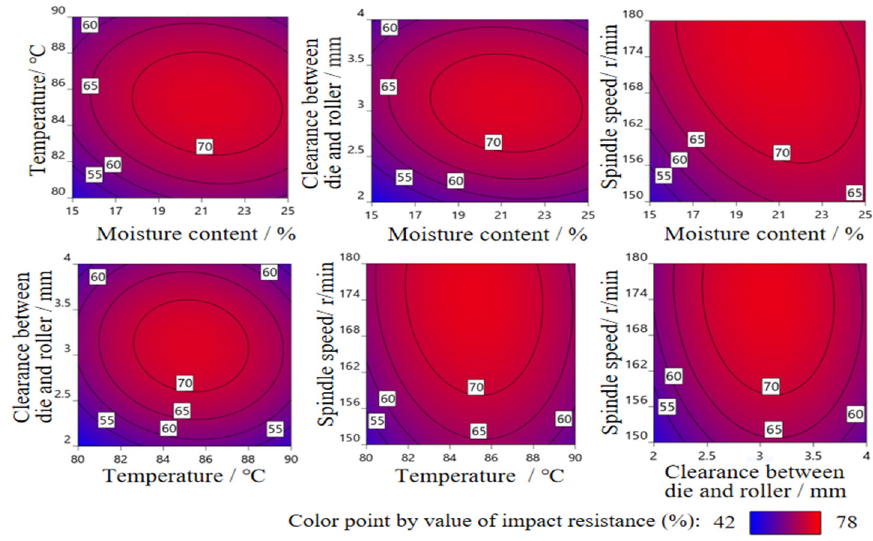
Figure 8. Contour sheet of impact resistance.